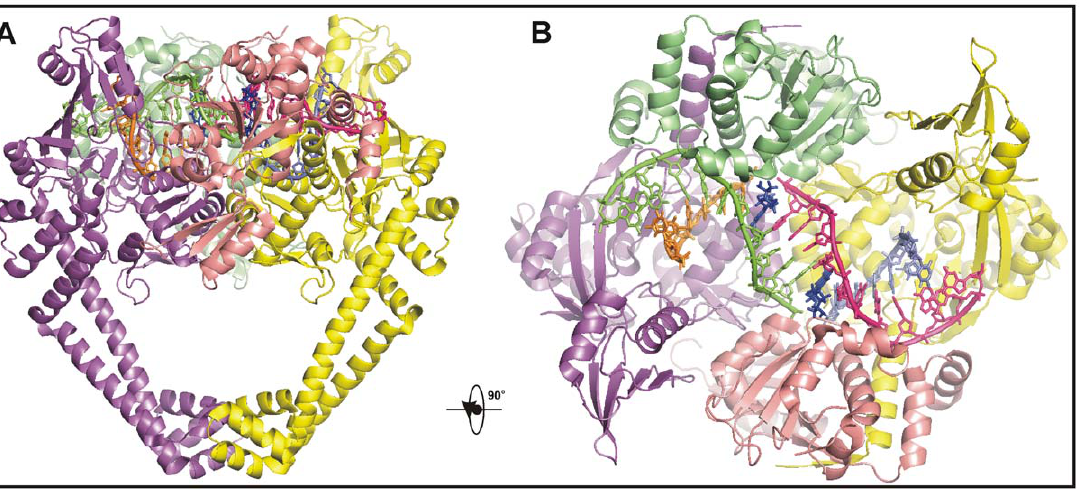
Figure 1. Architecture of a dione-arrested DNA complex of topoisomerase IV. A–B , Orthogonal views of the topo IV-DNA complex stabilized by PD 0305970. ParC is in purple/yellow, ParE is in salad green/light rose, DNA strands are in pink, blue, orange and light-green, PD 0305970 is in dark blue.